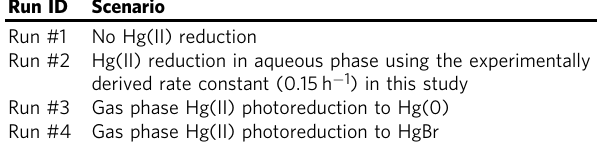
Table 1 Model test runs for different atmospheric Hg(II) reduction scenarios in the GLEMOS model Run ID